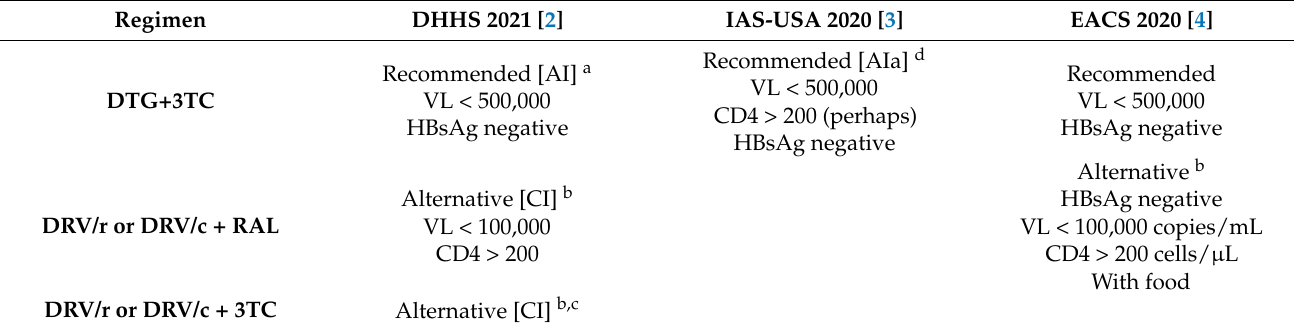
Table 1. Latest international recommendations for two-drug regimens in cART-naïve